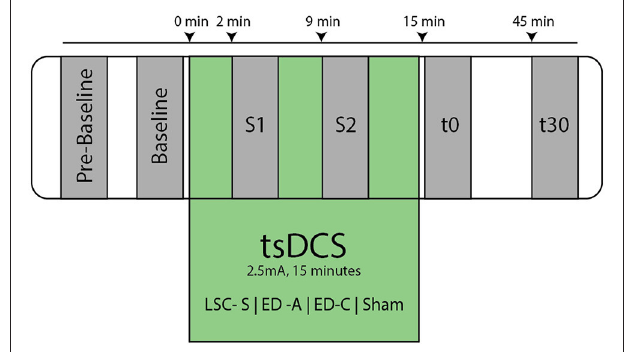
FIGURE 3 | Overview of experimental protocol. At Pre-Baseline an initial recruitment curve mapping took place to determine characteristic points within the H- and M- Wave recruitment curves (see Figure 2 ). After an additional baseline measurement, the tsDCS intervention was started with an amplitude of 2.5mA and a duration of 15min. During tsDCS, the H-reflex is probed after 2min (S1) and 9min (S2), measuring only H settle , H max , and M max . Post tsDCS measurements follow immediately (t0) and 30min (t30) after the